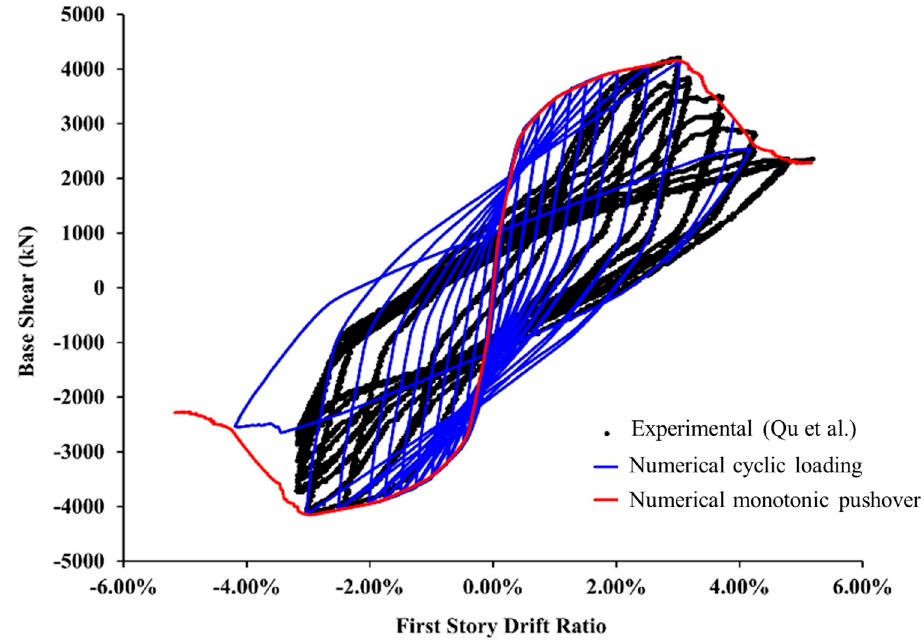
Figure 10. Comparison between numerical and experimental pushover curves for the two-story specimen by Qu et al.